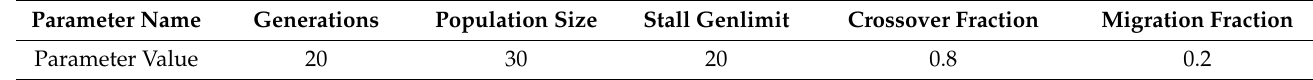
Table 2. The main parameters of the